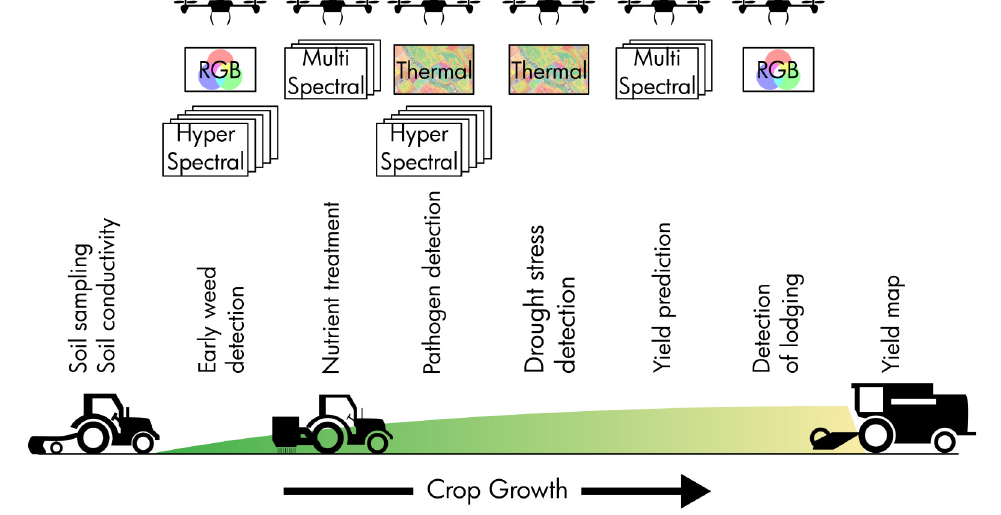
Figure 4. Schematic overview of the different ways to extract spatial information and the useful robotic platforms throughout a growing